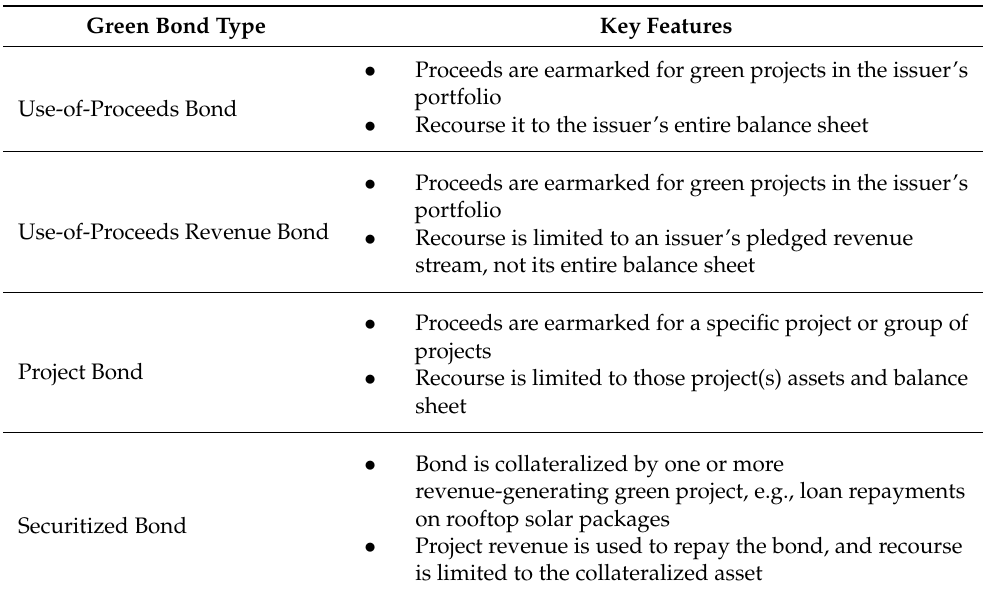
Table 1. Main features of the most used types of green